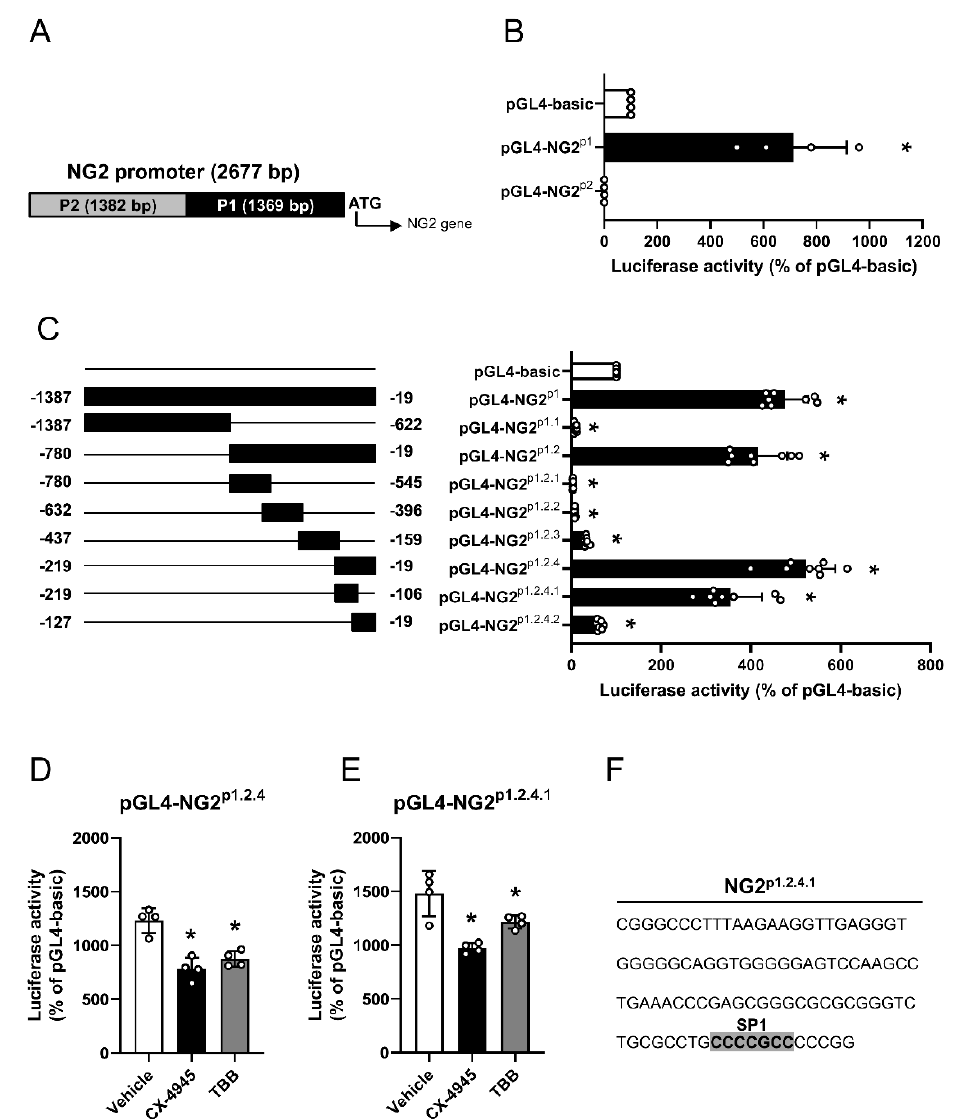
Figure 2. Characterization of the NG2 promotor region and identification of putative transcription factor binding sites. ( A ) Schematic illustration of the 2677 bp NG2 promoter region in front of the translational start, which contains the two overlapping truncated fragments P1 (1369 bp) and P2 (1382 bp). ( B ) HEK cells were transfected with pGL4-basic, pGL4-NG2 p1 or pGL4-NG2 p2 and the transcriptional activity was detected after 48 h by means of luciferase activity. Luciferase activity of pGL4-basic-transfected cells was used as control and set as 100%. Mean ± SD. * p < 0.05 versus pGL4-basic ( n = 4). ( C ) HEK cells were transfected with the indicated truncated fragments of pGL4-NG2 p1 and the transcriptional activity was detected after 48 h by means of luciferase activity. Luciferase activity of pGL4-basic-transfected cells was used as control and set 100%. Mean ± SD. * p < 0.05 versus pGL4-basic ( n = 8). ( D and E ) HEK cells were transfected with pGL4-NG2 p1.2.4 ( D ) or pGL4-NG2 p1.2.4.1 ( E ) for 24 h and treated with vehicle (DMSO), CX-4945 (10 µ M) or TBB (50 µ M). After 24 h, transcriptional activity was determined by luciferase activity. Luciferase activity of pGL4-basic-transfected cells was used as control and set as 100%. Mean ± SD. * p < 0.05 versus vehicle ( n = 4). ( F ) Nucleotide sequence of NG2 p1.2.4.1 (114 bp). The SP1 consensus sequence is highlighted in grey.